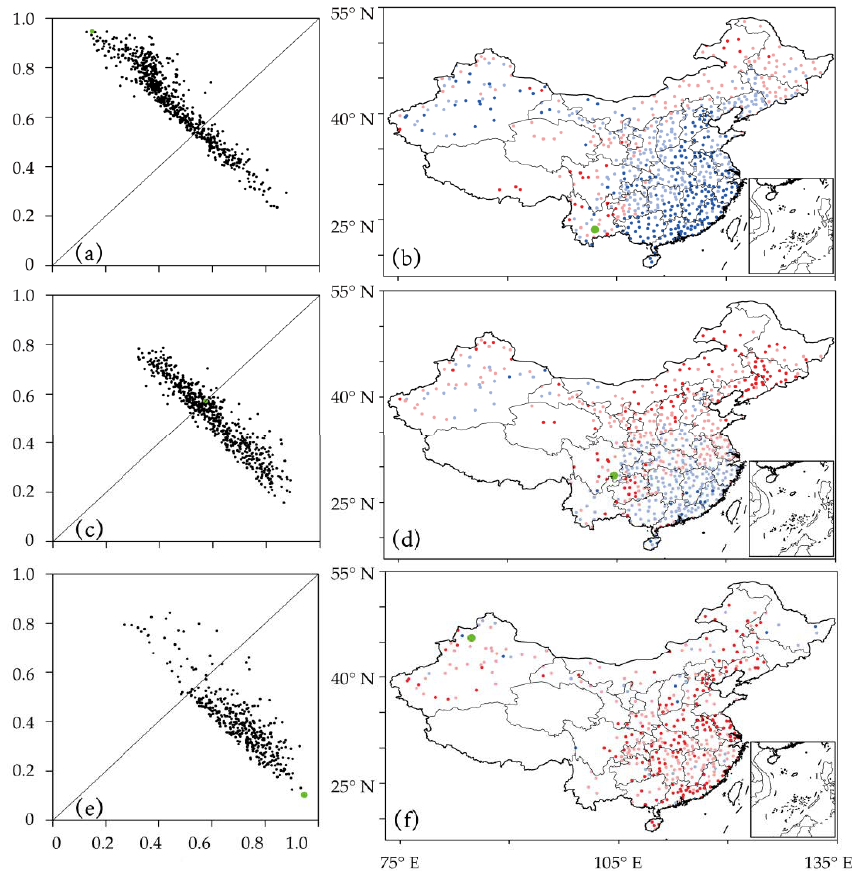
Figure 3. ( a ) Scatter plot at 28 °C, the black line is coefficient a = b ; ( b ) spatial distribution map at 28 °C; ( c ) scatter plot at 32 °C; ( d ) spatial distribution map at 32 °C; ( e ) scatter plot at 36 °C; ( f ) spatial 28 ◦ C; ( c ) scatter plot at 32 ◦ C; ( d ) spatial distribution map at 32 ◦ C; ( e ) scatter plot at 36 ◦ C; ( f ) spatial distribution map at 36 °C. distribution map at 36 ◦